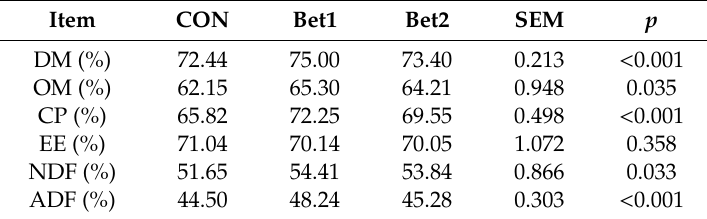
Table 4. E ff ect of betaine on the apparent digestibility of dairy cows. Item CON